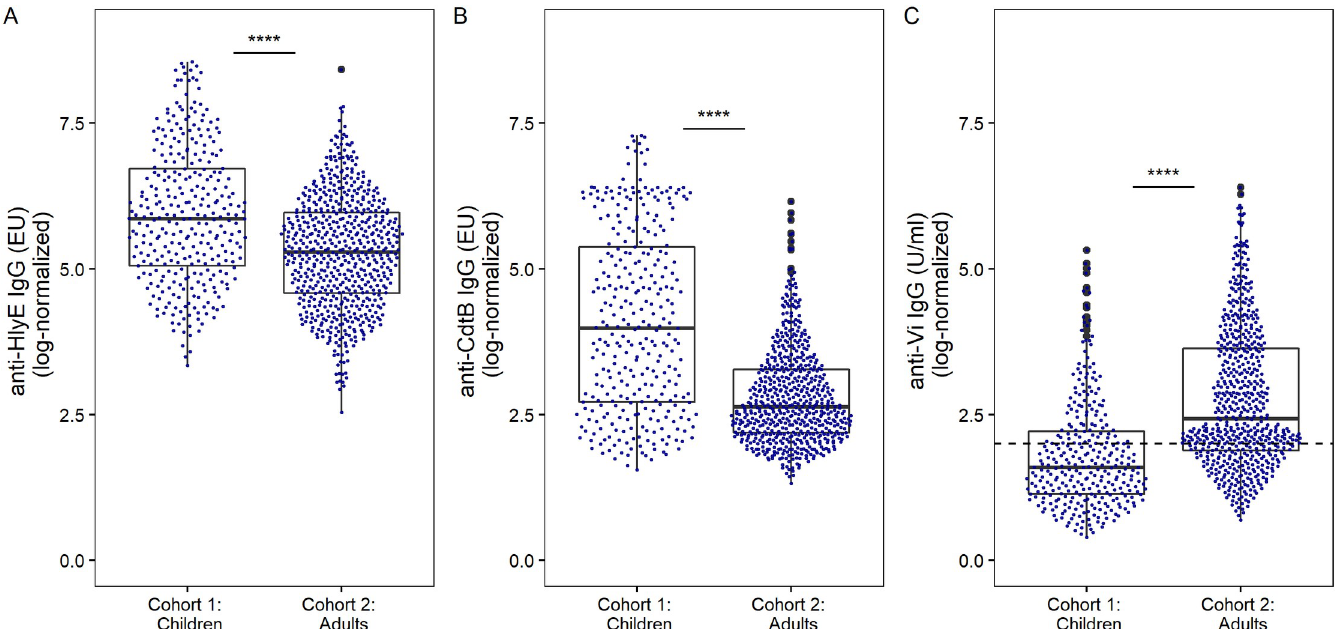
Fig 1. The distribution of anti– S . Typhi serum IgG titers in children and adults in Lao PDR. Each dot shows the antibody titer of an individual sample for (A) anti- HlyE IgG, (B) anti-CdtB IgG, and (C) anti-Vi IgG with an underlying boxplot. The dashed line in panel C represents the censoring limit, all data points below were treated as left-censored data. Differences between groups were assessed using Wilcoxon rank sum test followed by Dunn’s post-hoc test with Bonferroni correction: ���� p <